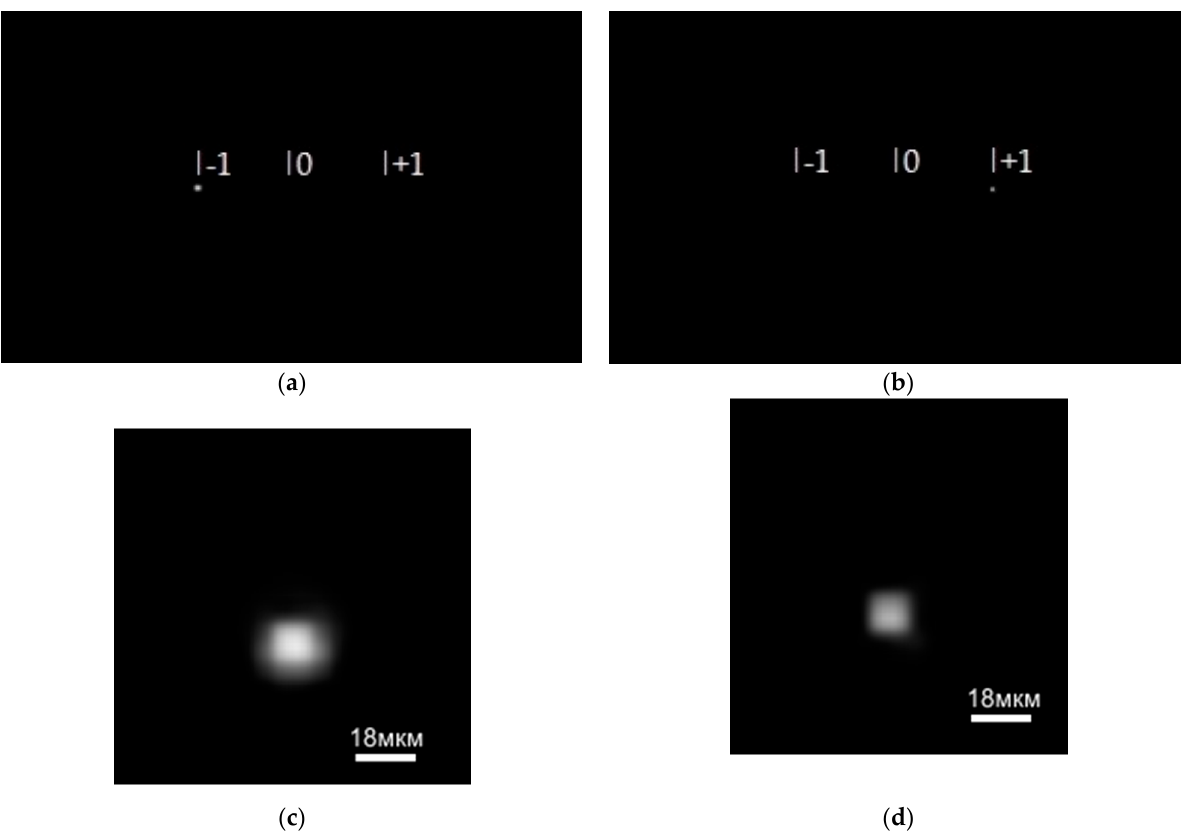
Figure 5. Diffraction orders on the matrix for wavelengths of ( a ) 900 nm, ( b ) 970 nm, and ( c , d ) their respective magnified images.